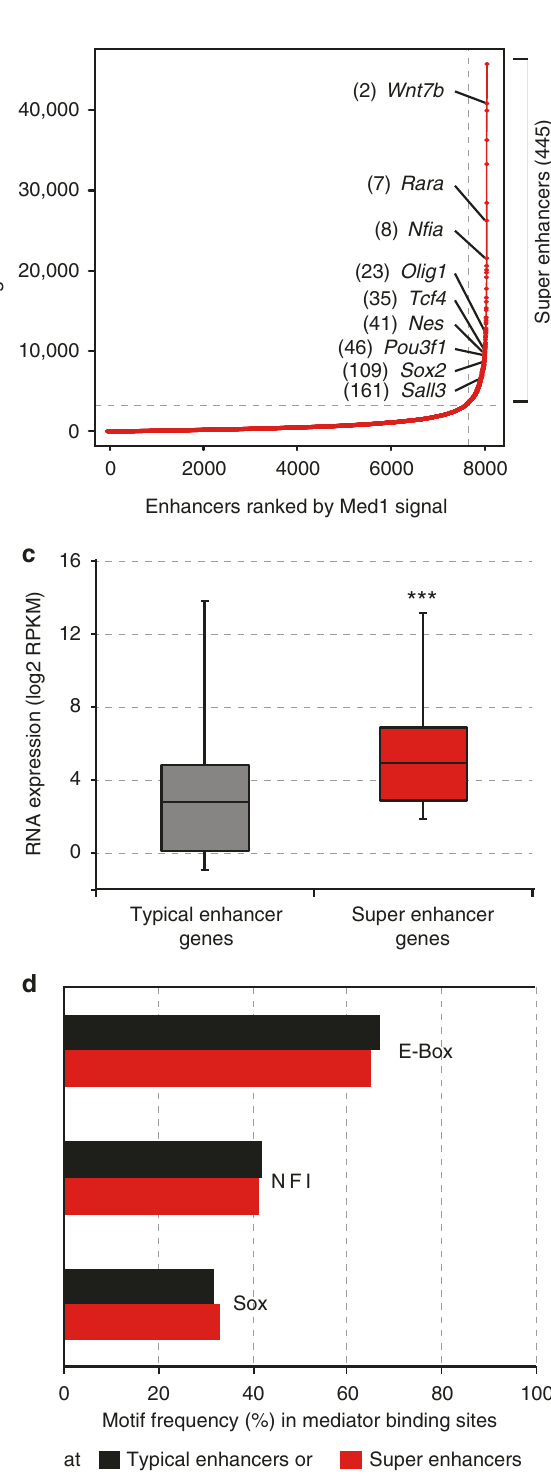
Fig. 3 Super enhancers in neural stem cells. a Distribution of Med1 ChIP-seq signal (total reads) in enhancer regions in NSCs. 445 enhancers regions in the right upper quadrant are postulated as super enhancers. Examples of genes near super enhancers and the super enhancer rank are indicated. Source data are provided as a Source Data fi le. b Top 25 super enhancers (SEs) in NSCs, ranked by Mediator content, and their nearest active gene (left panel). Top 25 active transcription factor genes nearest to SEs (Right panel). SE rank is indicated. Genes encoding transcription factors that we identi fi ed as Mediator interactors are red-shaded. c Distribution of mRNA expression in NSCs of active genes nearest to SEs and active genes nearest to typical enhancers, but not nearest to SEs. Whiskers represent ultimate range. Signi fi cance of the difference in mRNA levels between two gene categories was assessed by Student t -test (*** p < 0.001). Source data are provided as a Source Data fi le. d Most frequent transcription factor DNA motifs in Mediator-binding sites at typical enhancers and SEs. Motif frequency is indicated as the percentage of all Mediator-binding sites at typical enhancers or SEs that harbour this